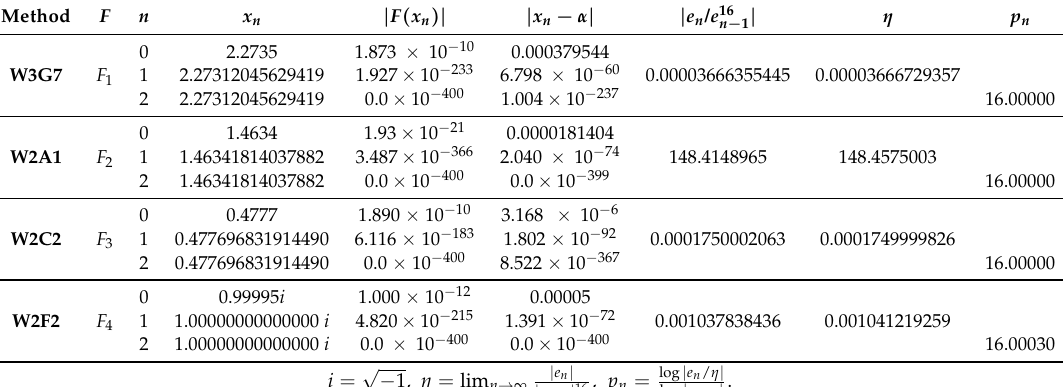
Table 2. Convergence of methods W3G7, W2A1, W2C2, W2F2 for test functions F 1 ( x ) − F 4 ( x ) .